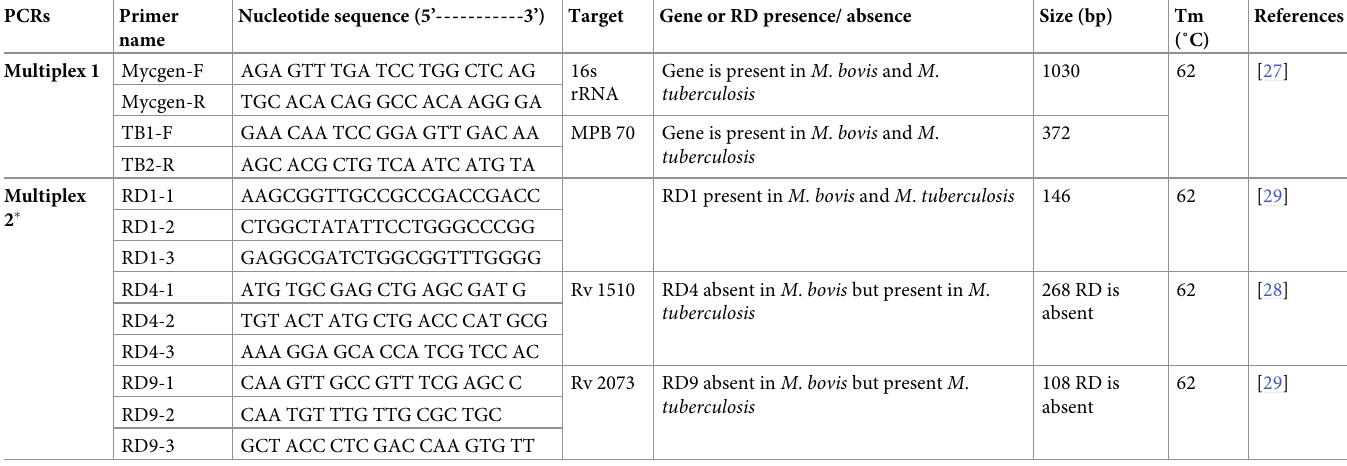
Table 1. Oligonucleotides used to identify Mycobacterium species isolated from slaughtered cattle in